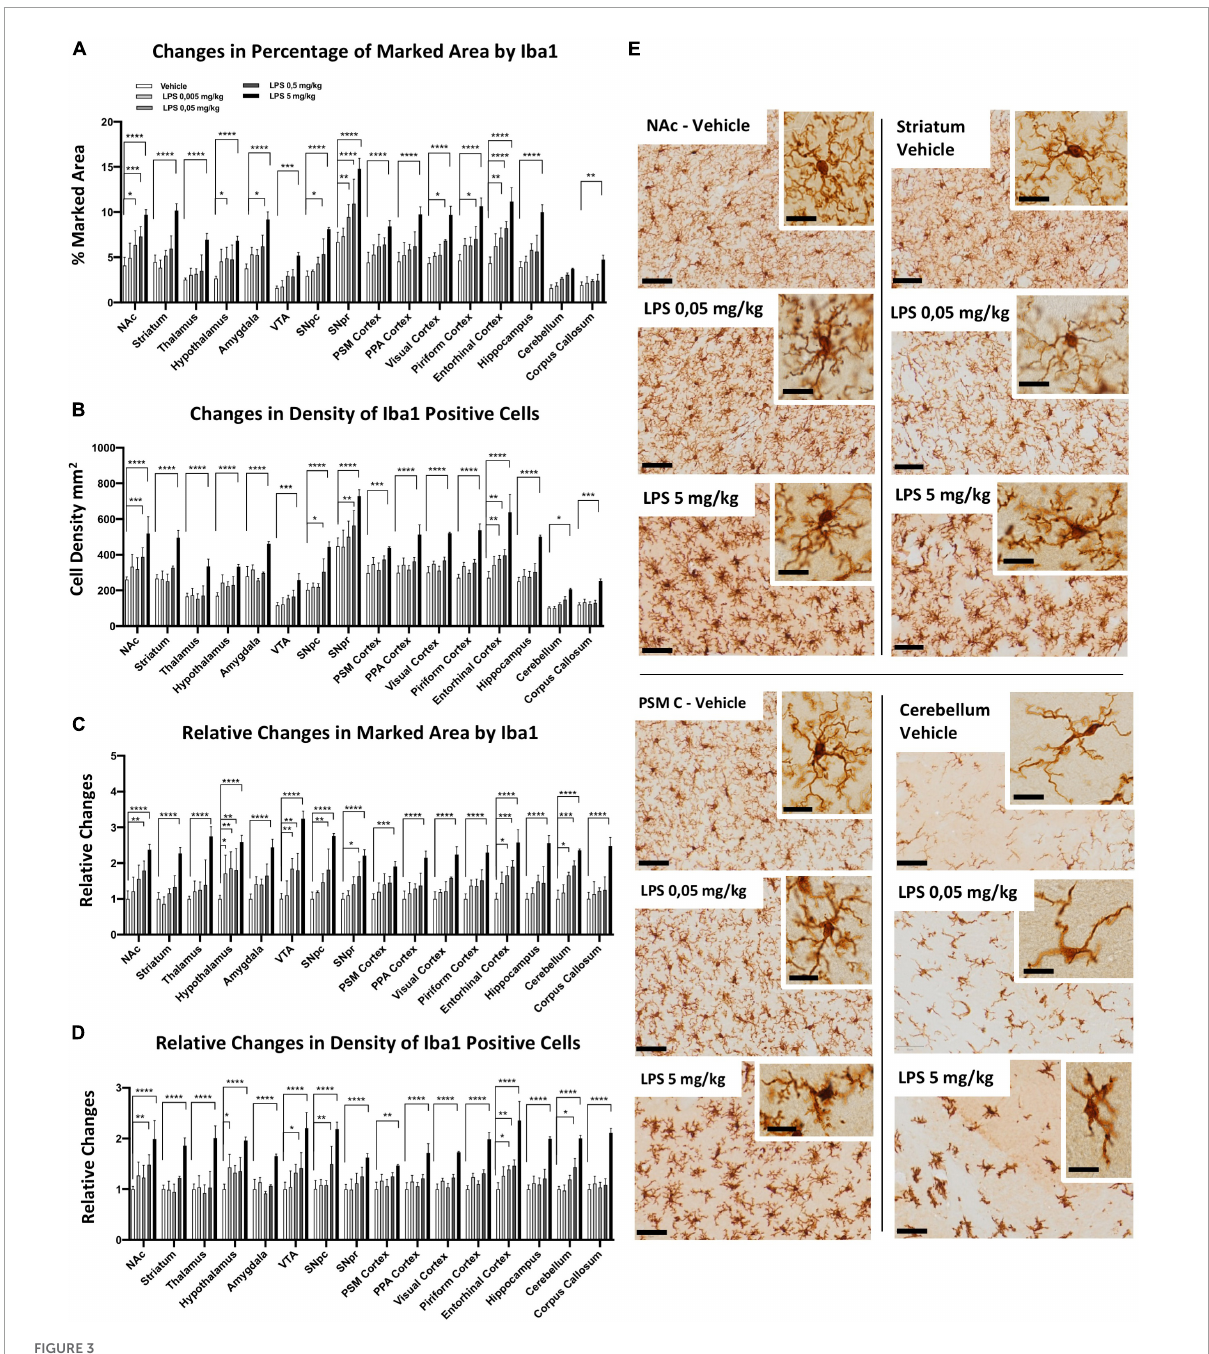
FIGURE3 Regional specific microglia activation to different doses of LPS in C57BL6 mice. (A) Percentage of marked area by Iba1 in vehicles (white columns), LPS treated mice with 0.005 mg/kg (clear gray columns), 0.05 mg/kg (medium gray columns), 0,5 mg/kg (dark gray columns), 5 mg/kg (black columns). Two-way ANOVA. F BrainRegions (15, 160) = 57.94, p < 0.0001. F Treatment (4, 160) = 188,3, p < 0.0001. F Interaction (60, 160) = 1.599, p < 0.0110, and n = 3 mice per region. Significance: respect relative vehicles. (B) Iba1 positive cell density mm 2 . Same column color as graph (A) . Two-way ANOVA. F BrainRegions (15, 160) = 112.7, p < 0.0001. F Treatment (4, 160) = 222.1, p < 0.0001. F Interaction (60, 160) = 2.039, p < 0.0002, and n = 3 mice per region. Significance: (*) Significance: respect relative vehicles. (C) Relative changes in percentage of area marked by Iba1. Same column color as graph (A) . Two-way. F BrainRegions (15, 160) = 4.169, p < 0.0001. F Treatment (4, 160) = 202.4, p < 0.0001. F Interaction (60, 160) = 1.259, p < 0.1304, and n = 3 mice per region. Significance: (*) respect relative vehicles. (D) Relative changes in Iba1 positive cell density. Same column color as graph (A) . Two-way ANOVA. F BrainRegions (15, 160) = 5.660, p < 0.0001. F Treatment (4, 160) = 247.6, p < 0.0001. F Interaction (60, 160) = 1.848, p < 0.0013, and n = 3 mice per region. Significance: (*) respect relative vehicles. (E) Representative images of Iba 1 staining in Veh, 0.05 and 5 mg/kg LPS doses in NAc, striatum, PSM cortex and cerebellum. Scale bars = 50 um in (E) and 10 um